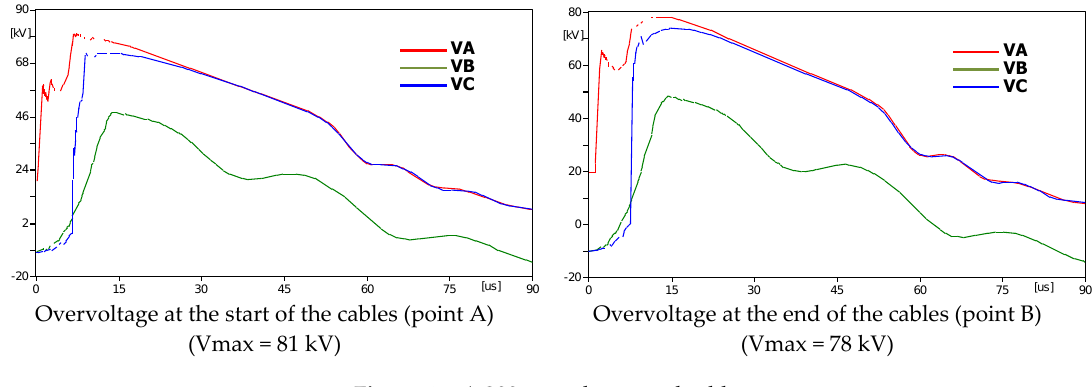
Figure 43. A 200 m underground cable. Energies 2019 , 12 , x FOR PEER REVIEW